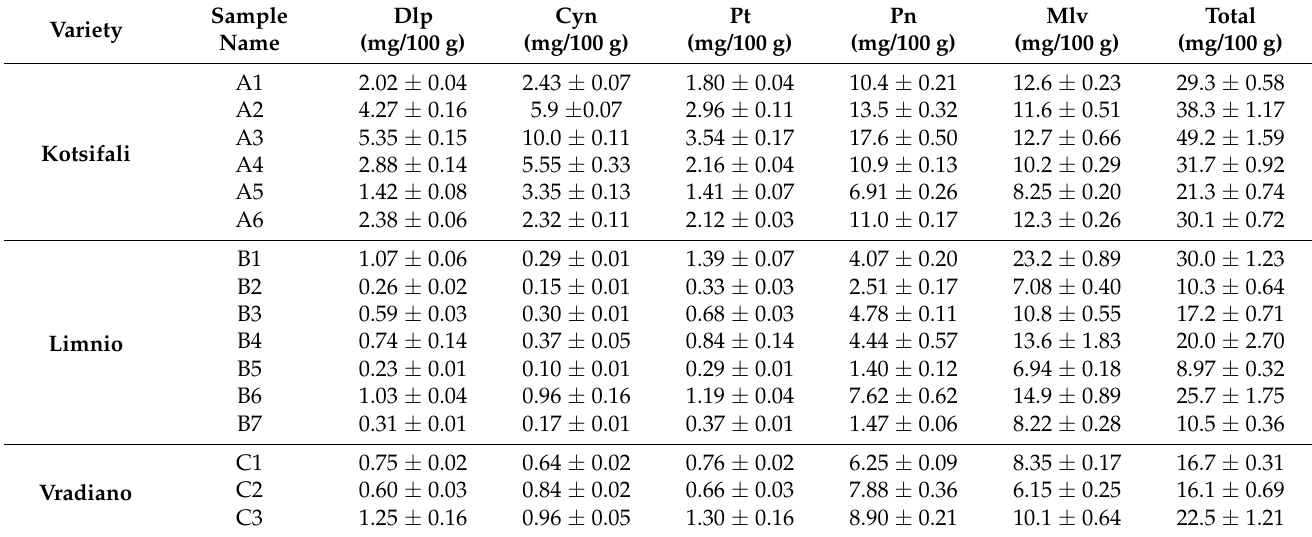
previously. Table 7. Anthocyanin concentration levels in red grapes of ‘Kotsifali’, ‘Limnio’, and ‘Vradiano’ (samples analyzed in triplicate, n =3 ±